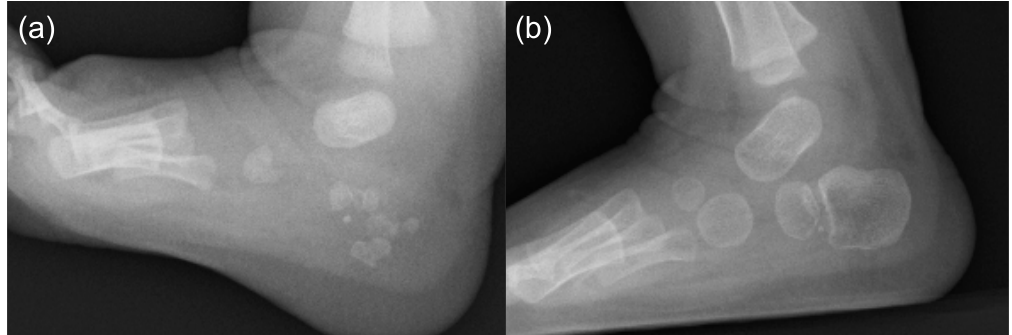
Figure 7. Lateral foot radiographs of a FOP boy at 3 months of age ( a ) and 11 months of age ( b ). Punctate multiple ossifications in early infancy gradually changed to double ossification centers.